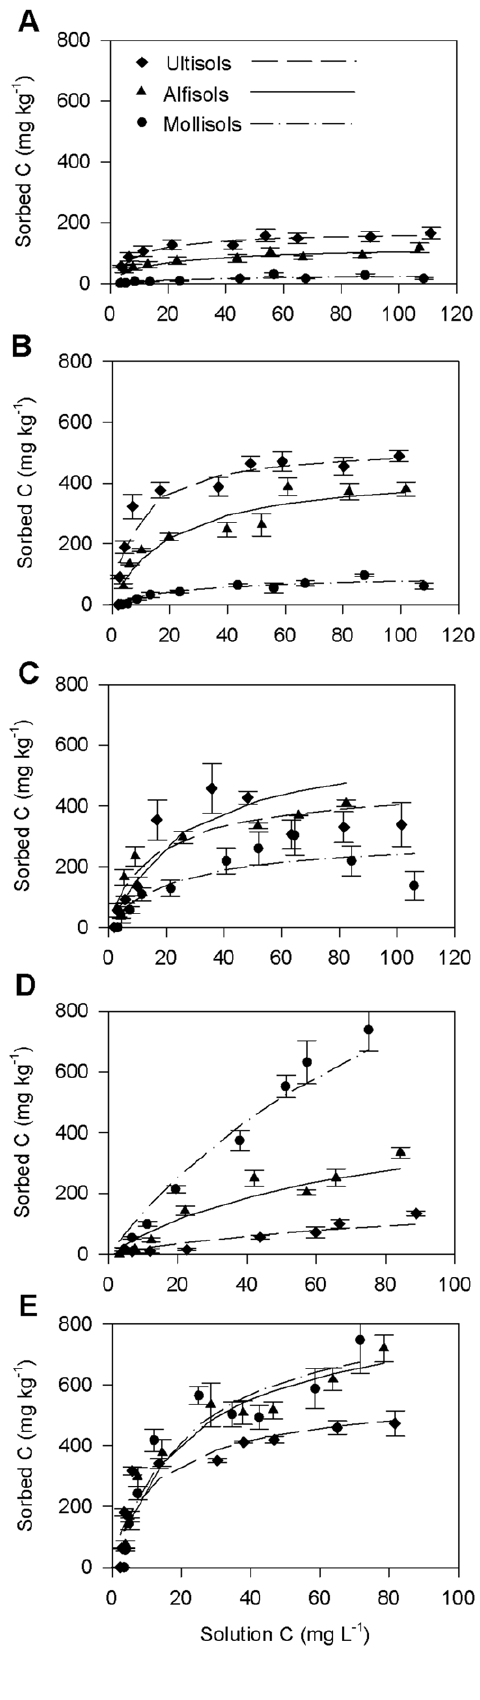
Figure 2. Sorption isotherms and Langmuir fits of organic carbon compounds on different soil orders. (A) D-Glucose, (B) L- Alanine, (C) Salicylic acid, (D) Sinapyl alcohol and (E) Oxalic acid. Each isotherm per soil order is an average of three soils except for Mollisols in (E) where only one soil type (Longford) is considered. Symbols correspond to measured sorption and lines correspond to Langmuir